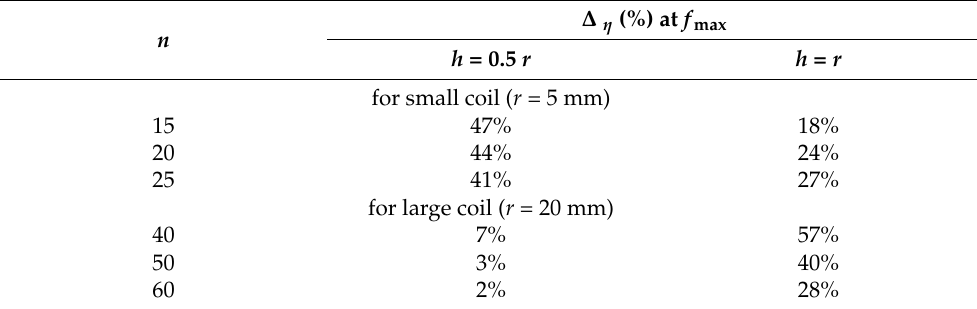
Table 11. The difference between the efficiency of the system in the periodic model and the aperiodic model with the use of square